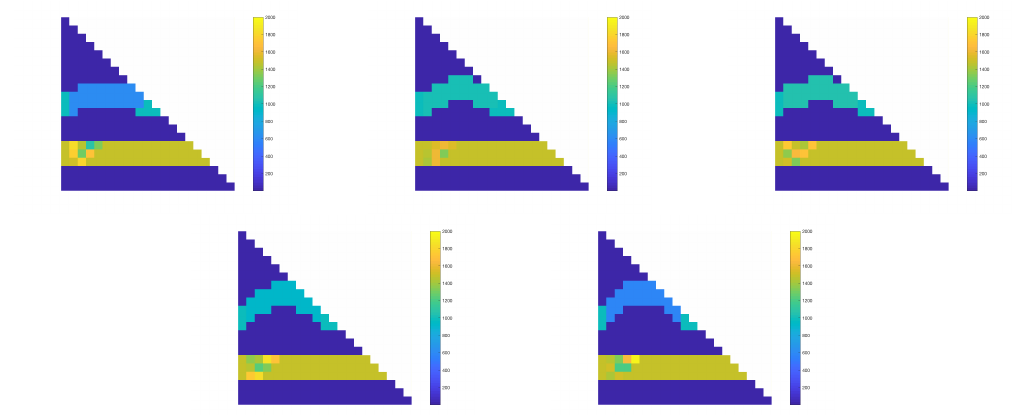
Figure 6. Samples of permeability fields in the target block K 0 in experiment